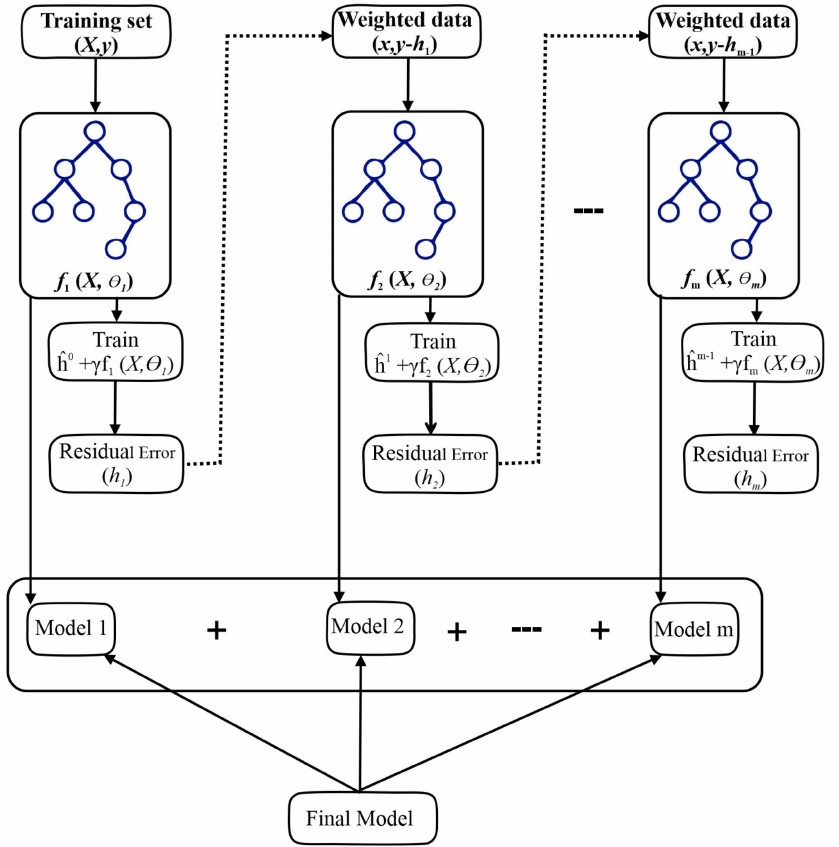
Figure 4. Schematic diagram of the GBRT